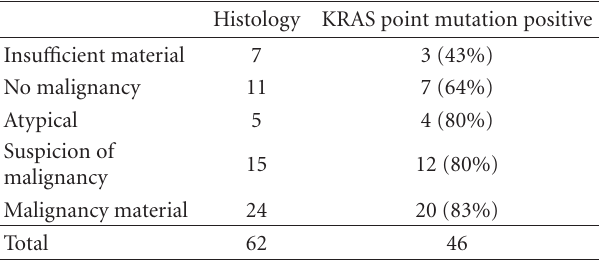
Table 2: Relationship between histopathologic evaluation and KRAS point mutation in specimens of pancreatic cancer (62 cases) obtained by EUS-FXA; citation from